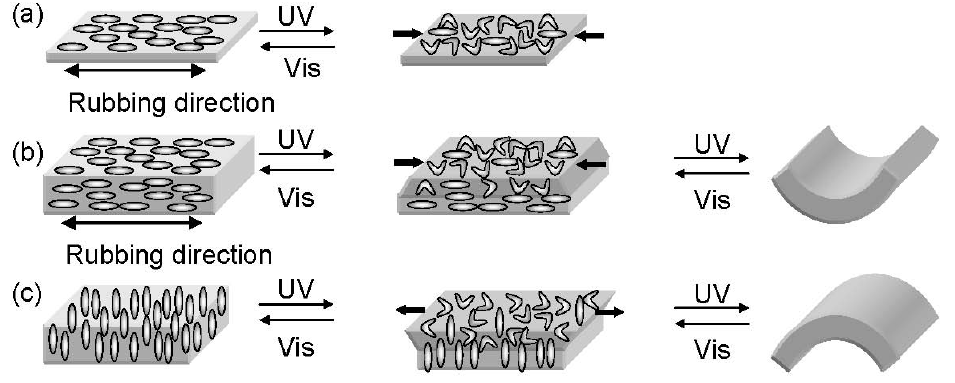
Figure 1. Schematic figure of phototriggered film bending in ( a ) homogeneously aligned thin film, ( b ) homogeneously and ( c ) homeotropically aligned thick film, respectively. Irradiation is applied from the top of the